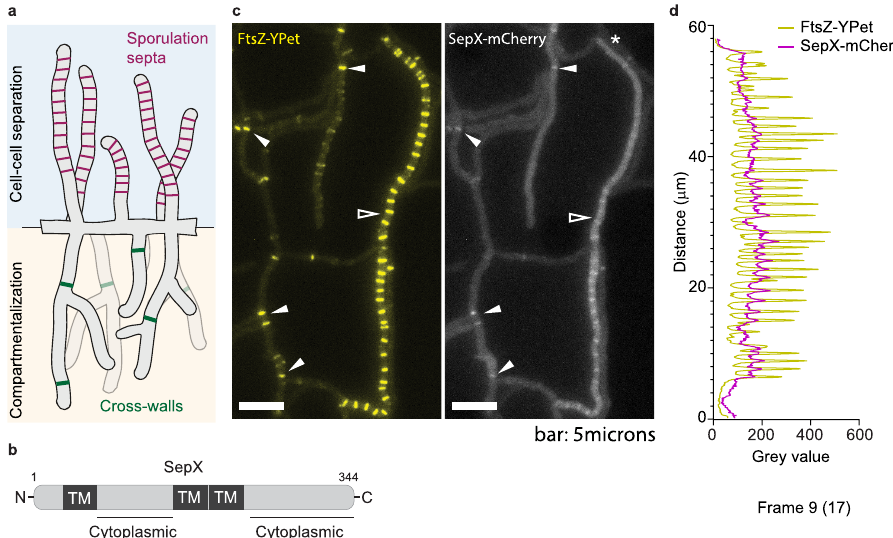
Fig. 1 SepX co-localizes with FtsZ at cross-walls and sporulation septa. a Schematic showing the two kinds of division septa that are formed in Streptomyces : vegetative cross-walls (green) and sporulation septa (magenta). b Schematic depicting the predicted domain organization of SepX ( vnz _ 14865), including three transmembrane (TM) segments and two cytoplasmic loops. Numbers denote amino acid count. c Microscopic analysis of a merodiploid strain expressing both a SepX-mCherry fusion and a FtsZ-YPet fusion (MB256) reveals that SepX and FtsZ co-localize at both cross-walls ( fi lled arrows) and sporulation septa (open arrow). Shown is a single frame from Supplementary Movie 1. Experiments were performed in duplicate. Scale bar: 5 μ m. d Intensity pro fi les of FtsZ-YPet and SepX-mCherry fl uorescence extracted from the sporogenic hyphae (*) presented in panel ( c ). Source data are provided as a Source Data fi